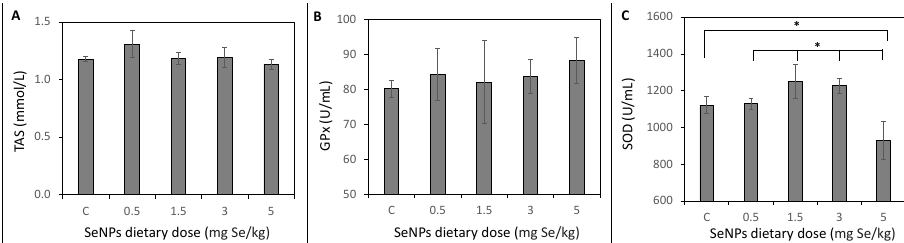
Figure 4. Antioxidant status of rats in the control group (C) and SeNP-enriched diet. ( A ) Total antioxidant status in blood, ( B ) GPx in blood and ( C ) SOD in the liver parenchyma. * Mean values were significantly different ( p < 0.05). Details of measurement are described in the Materials and Method